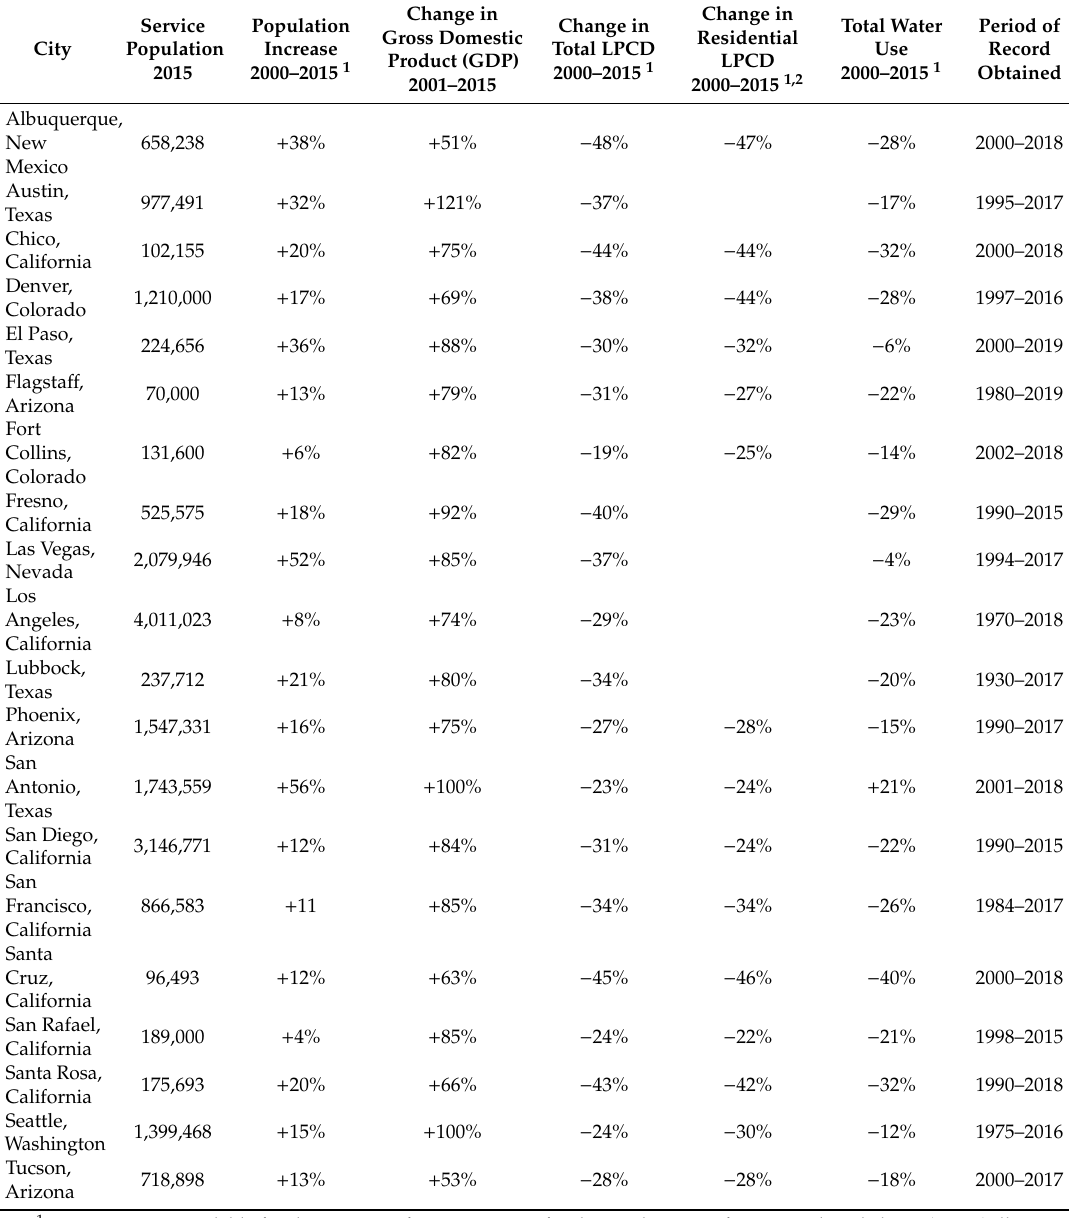
Table 1. Summary of survey